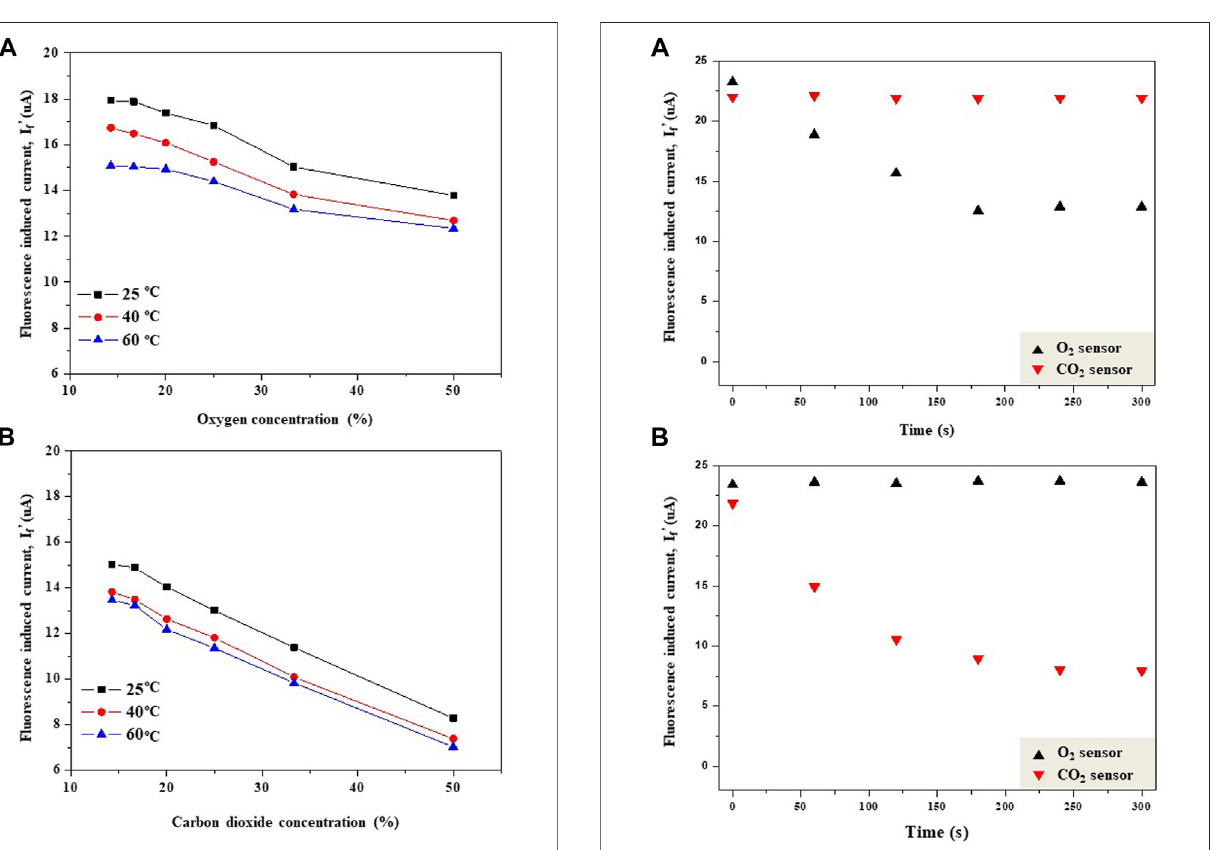
FIGURE 12 | Crosstalk measurements of the presented sensor; the responses of O 2 and CO 2 sensing units when injecting (A) O 2 gas, and (B) CO 2 gas, into the test